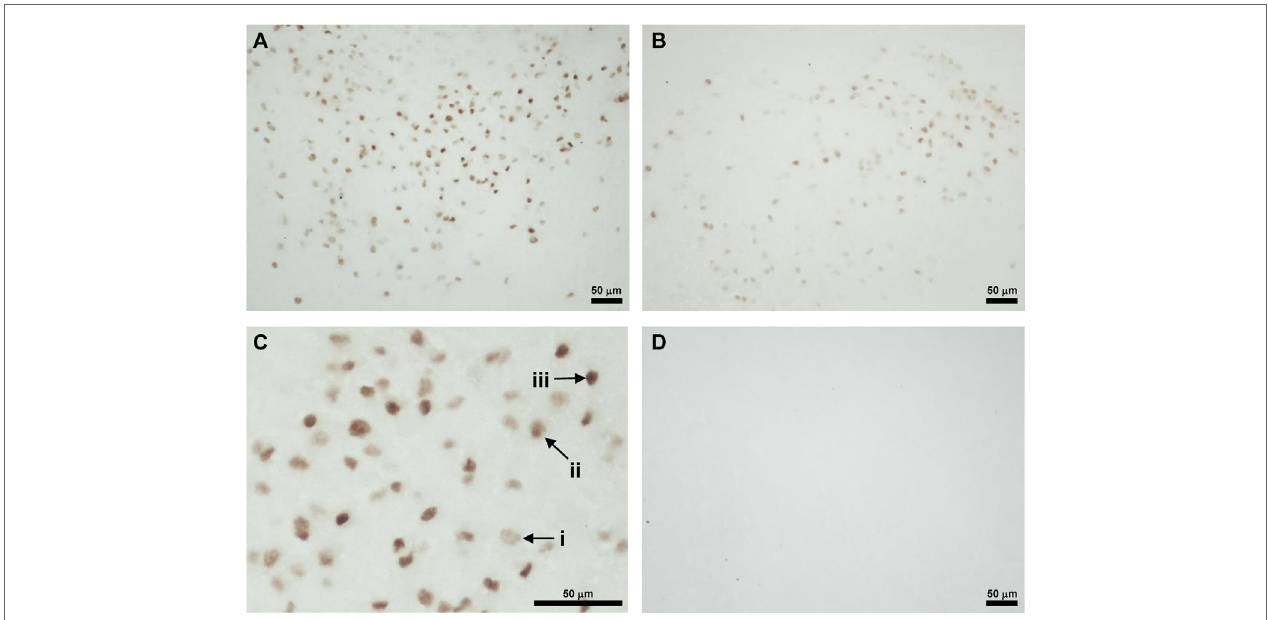
FigUre 3 | Location of Foxa1-immunoreactive cells in the neonatal male rat brain. (a) Foxa1-ir cells in the peduncular part of lateral hypothalamus (PLH) of vehicle treated P3 rat. (b) Foxa1-ir cells in the PLH of Bisphenol A treated P3 rat. (c) Higher magnification of Foxa1-ir cells in the PLH of vehicle treated P3 rat (a) . (i) A cell showing even staining in the cytoplasm and the nucleus. (ii) A cell showing darker staining in the nucleus than the cytoplasm. (iii) A cell showing intense staining only in the nucleus. (D) Immunohistochemistry without the first antibody showed no immunoreactive cellular